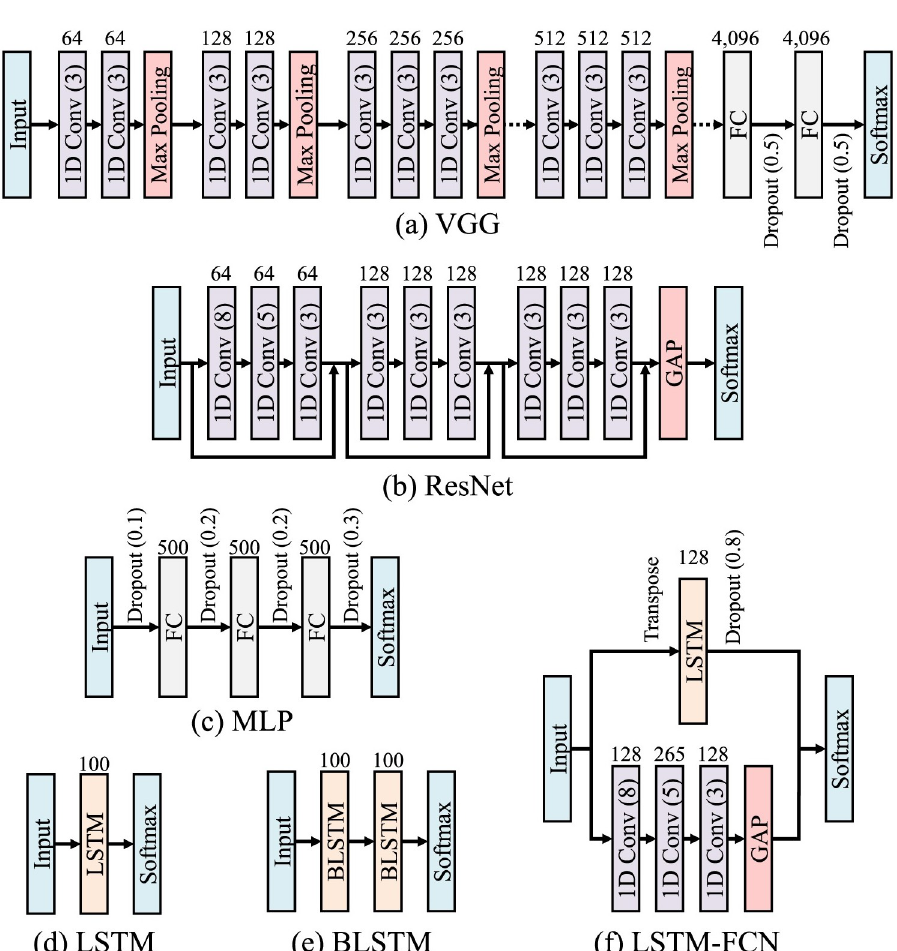
Fig 3. The architectures of the neural networks used to evaluate the data augmentation